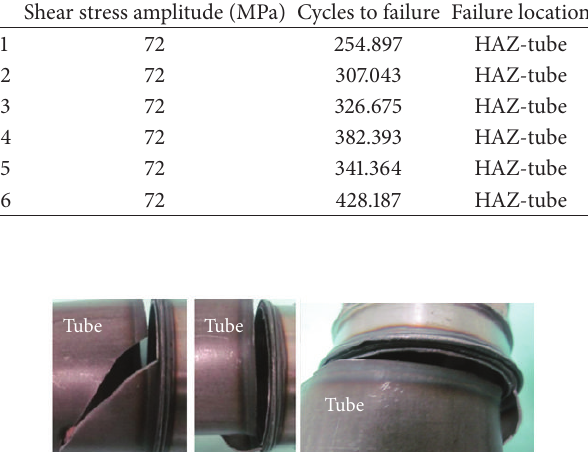
Table 2: Results of fully reversed ( 𝑅 = −1 ) torsional fatigue tests. Shear stress amplitude (MPa) Cycles to failure Failure location